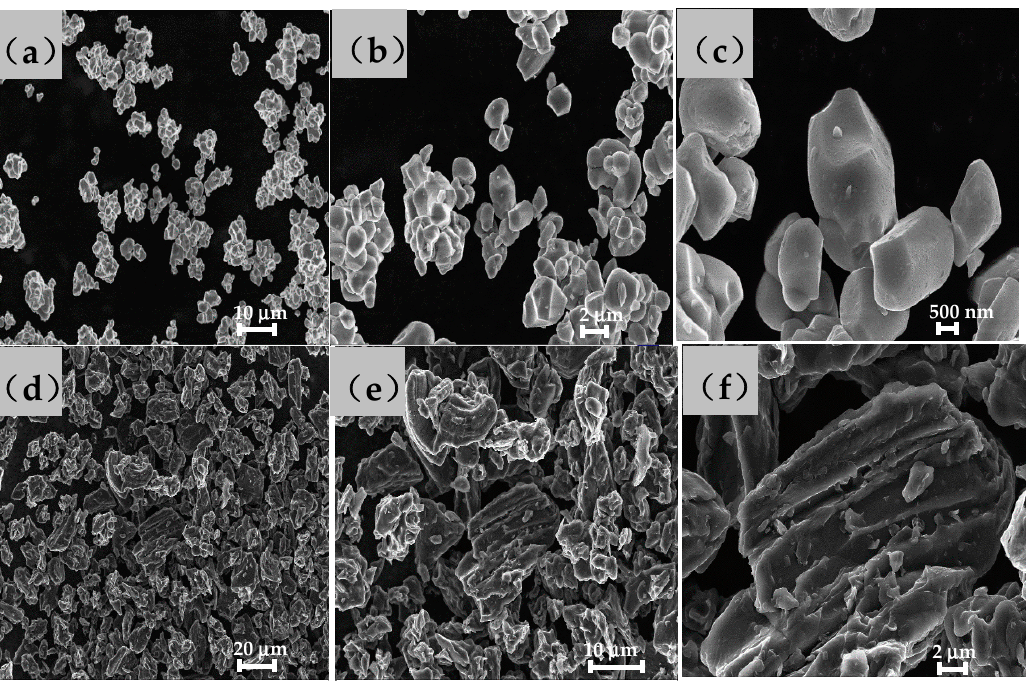
Figure 3. Morphology of ( a – c ) NCM523 and ( d – f ) graphite materials.